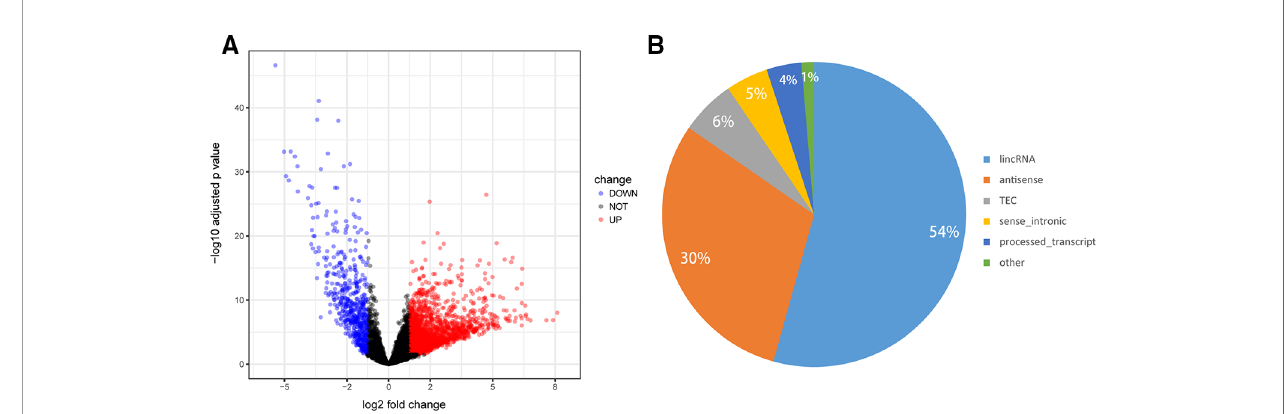
FIGURE 2 | Differential expression pro fi les of long noncoding RNAs (lncRNAs) in gastric cancer (GC). (A) Volcano plot of the differentially expressed lncRNAs between GC tumors and normal tissues. The red points represent lncRNAs that are signi fi cantly upregulated in GC while blue points represent downregulated lncRNAs (absolute FC >2 and FDR < 0.05). (B) Pie chart shows the number of differentially expressed lncRNAs in each